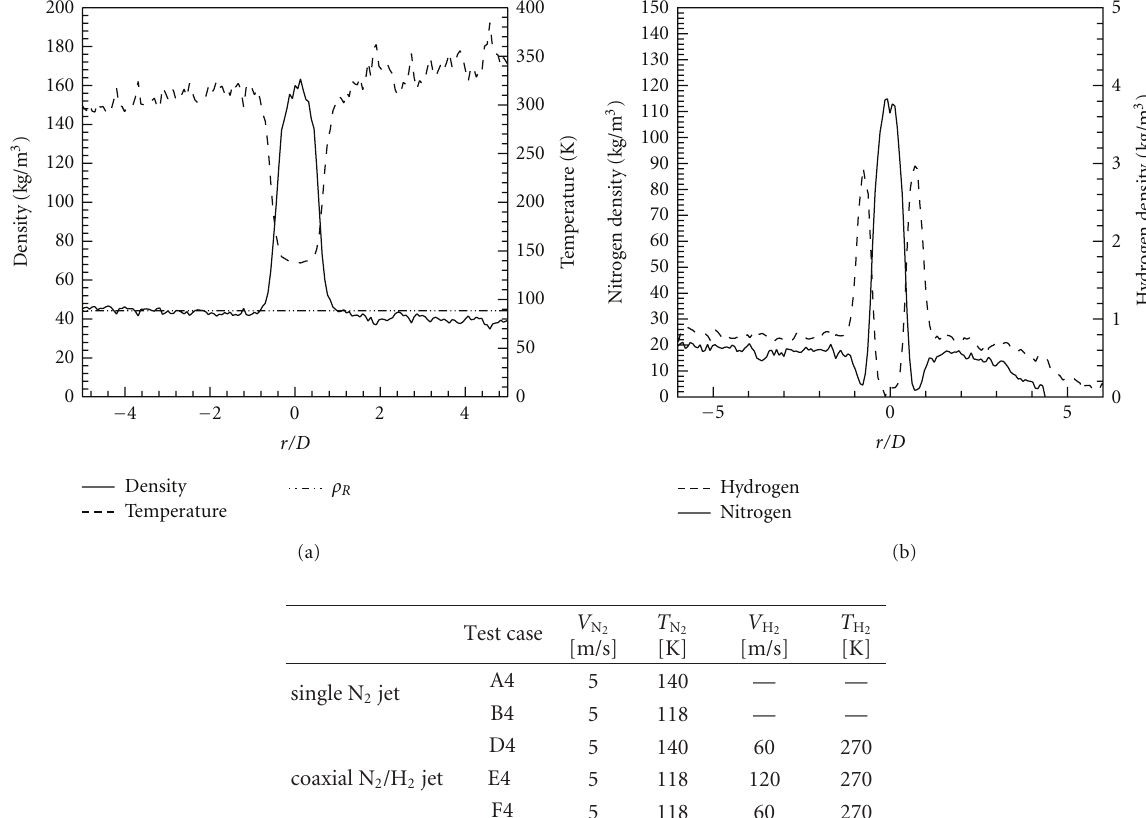
= 140K, T = 270K). Oschwald et H 2 2